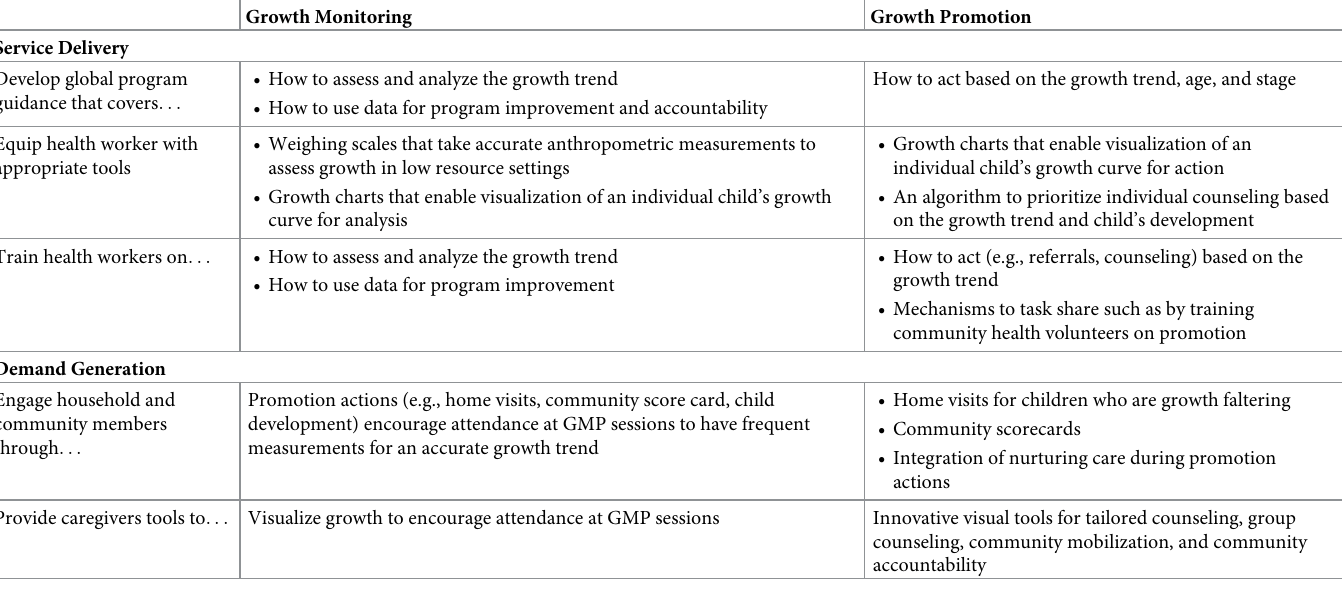
Table 5. Summary of recommendations for successful GMP